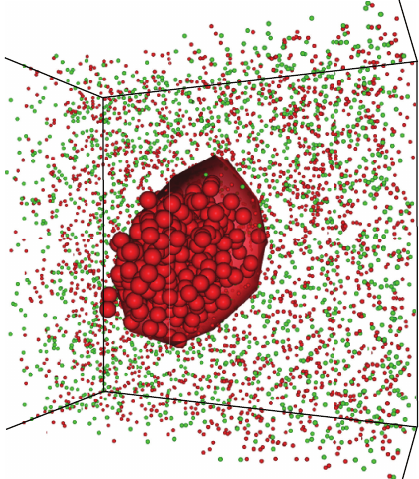
Figure 9: 3D atomic mapping of an individual Si-nc in silica matrix. Each dot corresponds to one atom (Si in red, O in green). The size of Si atoms belonging to Si-nc is artificially increased. The shown volume is 8 × 8 × 8nm 3